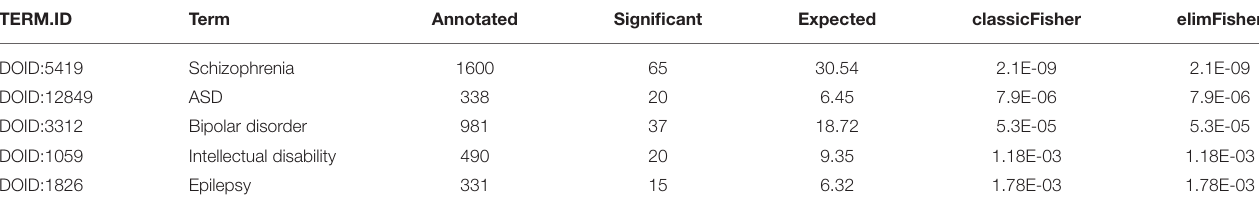
TABLE 1 | Disease enrichment of p140Cap related proteins. TERM.ID